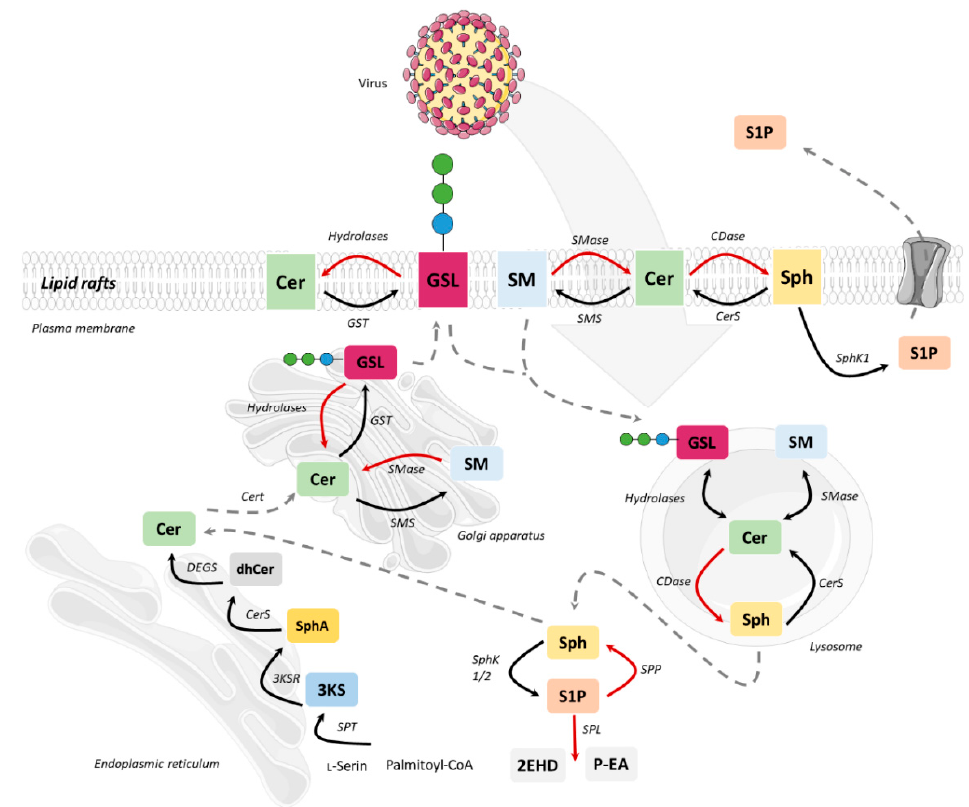
Figure 2. Schematic overview of the SL metabolism as potential target for viral interaction. After de novo synthesis in the ER, ceramide is transported to the Golgi apparatus via Cert. Ceramide is provided for the synthesis of complex sphingolipids such as sphingomyelin (SM) by sphingomyelin synthase (SMS) and glycosphingolipids (GSL) by glycosyl transferase (GST). Complex sphingolipids are transported from the Golgi apparatus to the plasma membrane or lysosomes. There the breakdown of SM to Cer takes place by sphingomyelinase (SMase), degradation of GSL occurs by